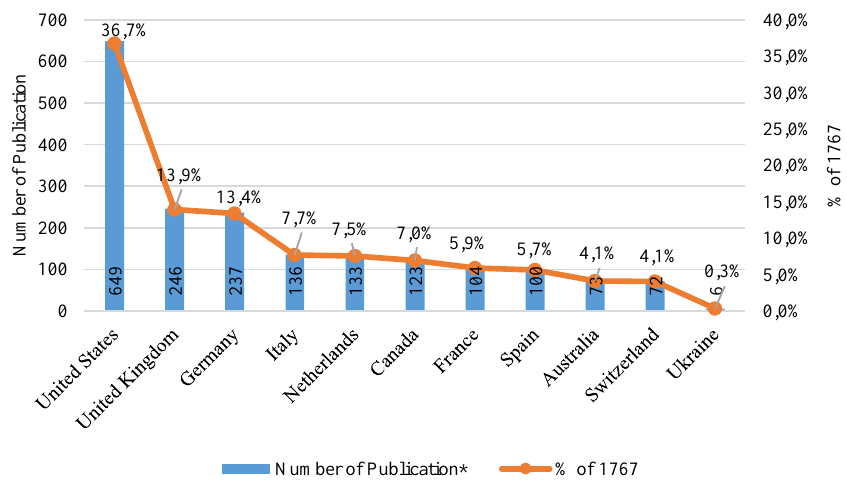
Figure 2. Countries with the Largest Number of Publications for the Search Query “Open Science” in Scopus *Note: The total number of publications is greater than 1767, since some studies were carried out in collaboration with scientists from other countries Source: Compiled by the authors using Scopus data (Scopus, n.d.)